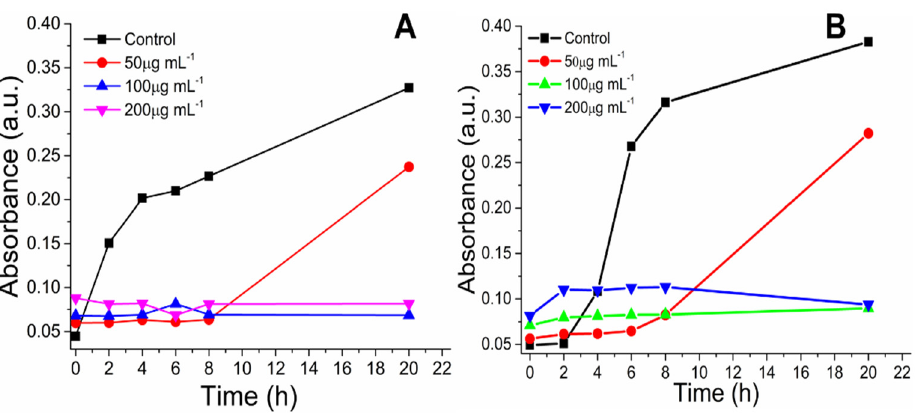
Figure 5. Growth curves of ( A ) S. aureus and ( B ) E. coli with various concentrations of the Ag-BSiO 2 - Fe 2 O 3 hybrid structure.